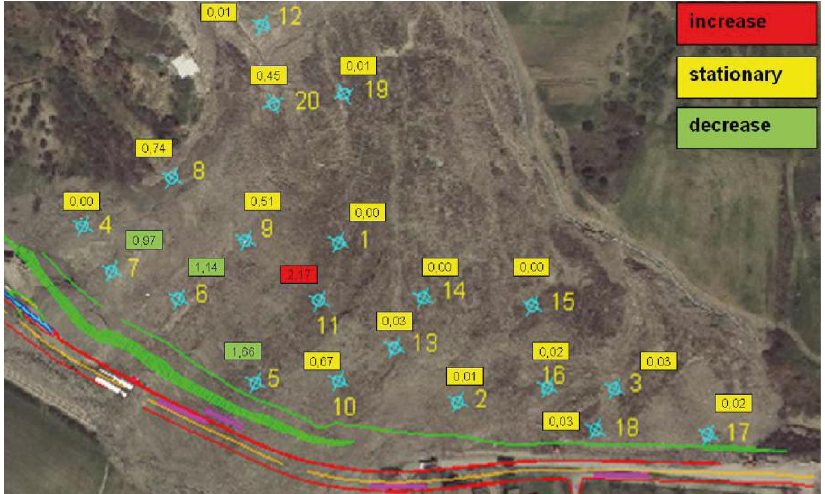
Figure 7. Example of the displacements synoptic map included in the bulletins. This representation can be considered as a precursor of the subsequent ©3DA representation.